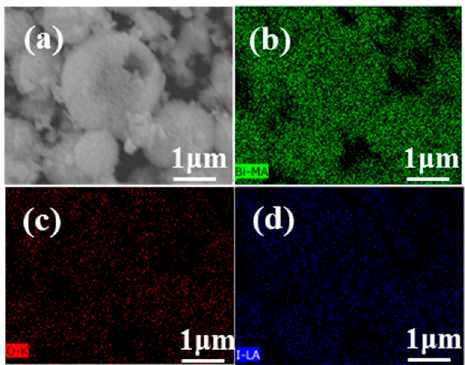
Figure 1. The SEM image of the I-deficient bismuth oxyiodide ( a ) and Bi, O, I elemental maps of I-deficient bismuth oxyiodide ( b – d ).